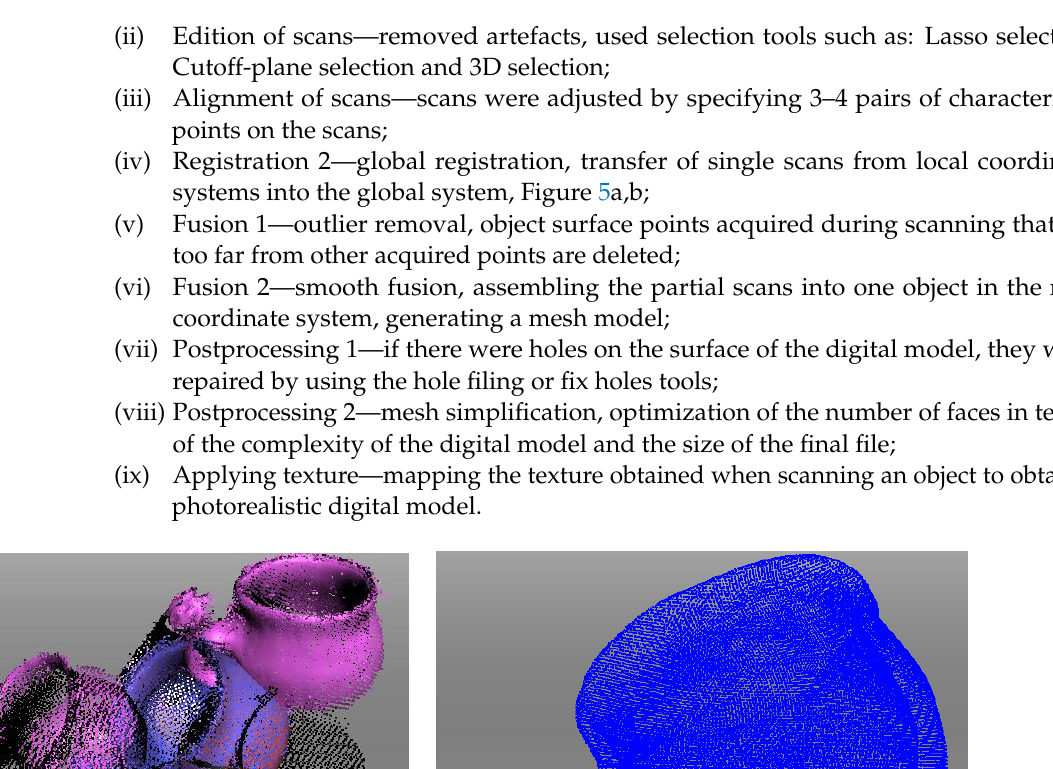
9 of 19 Figure 4. View of: ( a ) the scanning process; ( b ) data processing from the scanning; ( c , d ) the 3D mesh model; ( e , f ) the textured 3D mesh model. Processing was carried out using a desktop computer with an Intel Core i7 processor, 48 GB of RAM and an NVIDIA Quadro K2200 graphics card with built-in 4 GB GDDR5 memory. The use of equipment with high computing power allowed for efficient data processing activities. As a result, mesh digital 3D models with the texture applied were obtained (Figure 4c – f). The models were exported as files in the .obj format, and textures